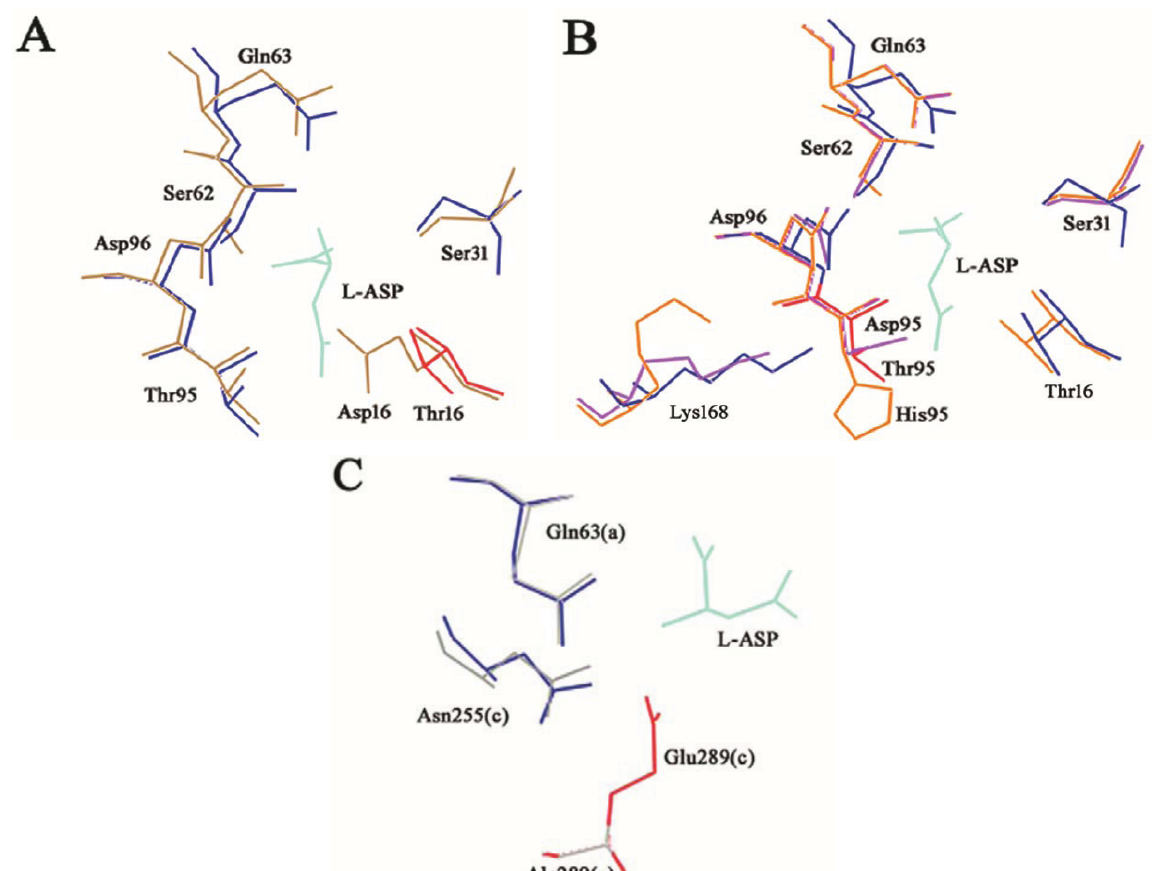
Figure 4. T16E, T95D, T95H and E289A HpASNase mutants’ structural models. The mutants models are superposed onto the HpA wild type crystal structure (blue lines, PDB ID: 2WLT [11]) and the native (replaced) residues are shown in red. Lower case letters indicate the subunit. The bonded product L -ASP is reported in all the models and represented as cyan lines. ( A ) T16E mutant model represented as sand lines. Residues S31, Q63, S62, D96 and T95 are as well reported being involved in structural interactions with the T16 residue. ( B ) T95D (pink lines) and T95H (orange lines) structural models. Residues T16, S31, Q63, S62, D96 and K168 are as well reported being involved in structural interactions with the T95 residue. ( C ) E289A (grey lines) structural model. Residues Q63 and N255 are as well reported being involved in structural interactions with the E289